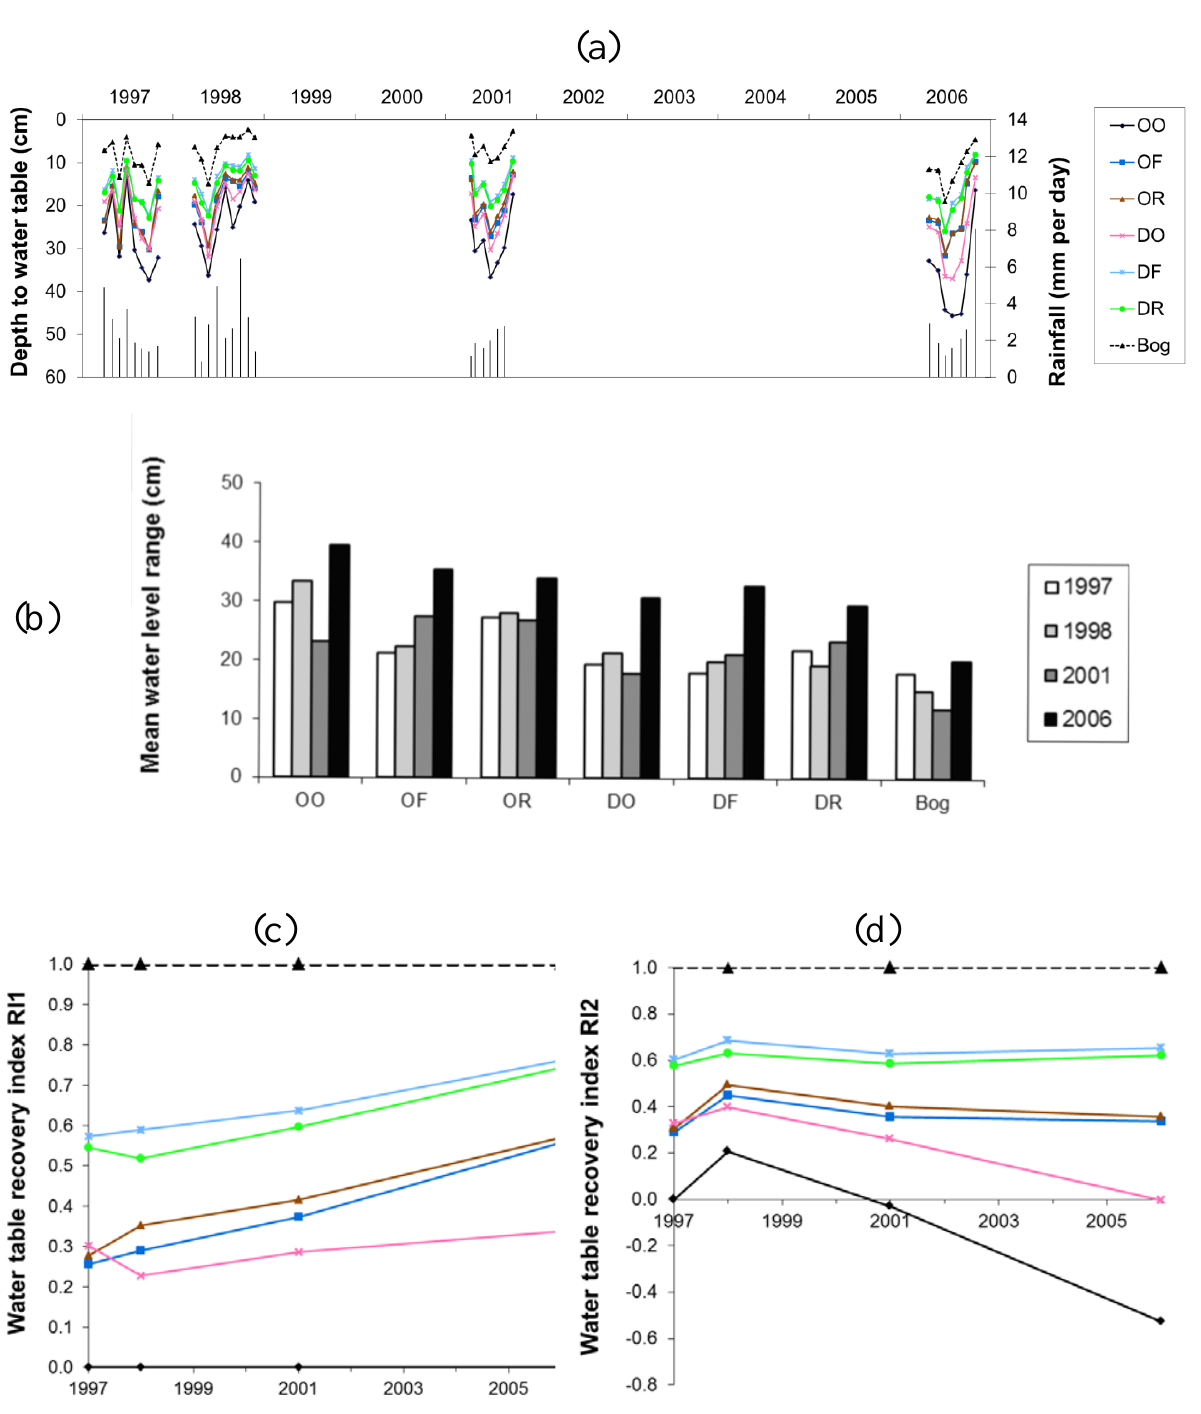
Figure 3. (a) Depth to water table for each treatment during the first, second, fifth and tenth growing seasons after applying the restoration treatments. Upper line: open bog adjoining the plots. Lowest line: control treatment, in which the trees continued to grow. The vertical bars represent the mean daily rainfall between dipwell readings. (b) Annual range of fluctuation of the water table by treatment and year using water level range gauges (walrags). The range for the undisturbed bog is shown for comparison. (c) Water table recovery index, RI1, which scales the water level for each treatment relative to that for the control (OO) (RI1=0) and the undisturbed bog (RI1=1). (d) Alternative recovery index, RI2, which scales the treatment water table using the 1997 (Year 1) control level as the baseline (RI2 = 0) and each year’s reference bog level as the ceiling (RI2 = 1). The key to treatments for (c) and (d) is the same as for